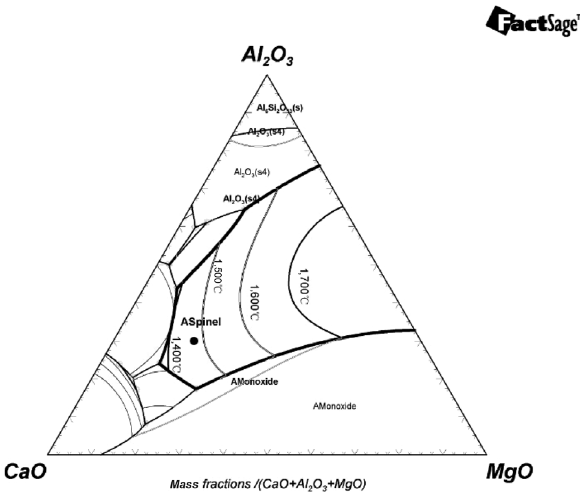
Figure 2: Phase diagram of CaO-Al 2 O 3 -MgO